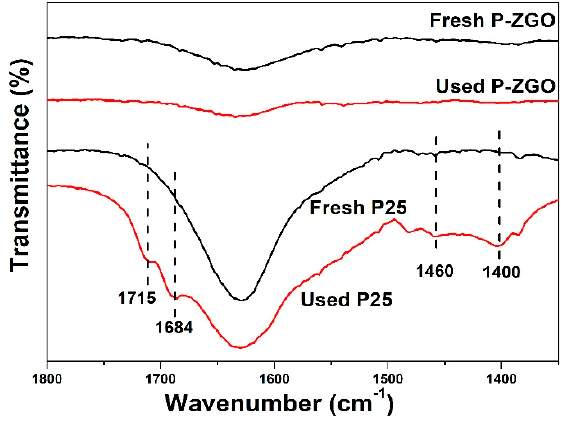
Figure 6. The FT-IR spectra of P-ZGO and TiO 2 before and after 60 h of photocatalytic degradation of toluene.